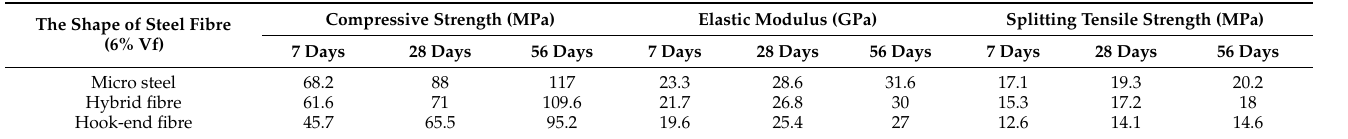
Table 3. Summary of the mechanical properties of the SIFCON.